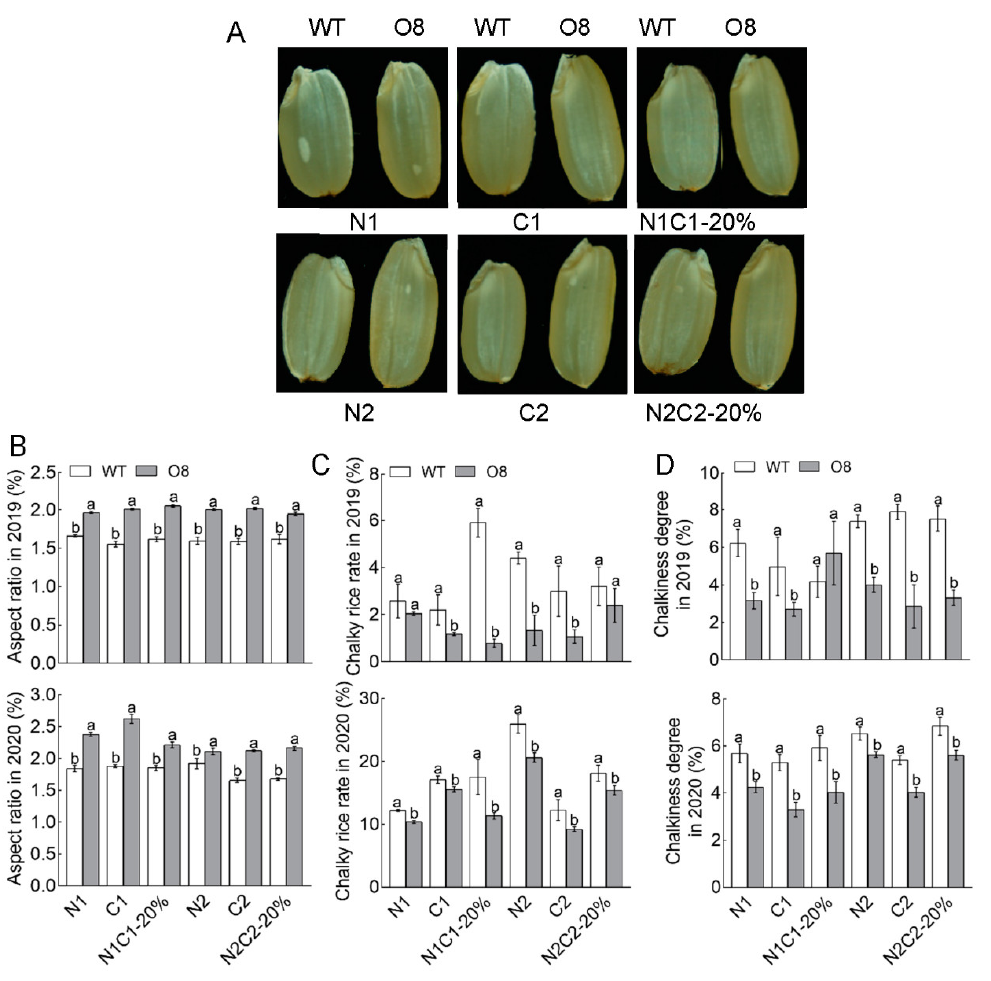
Figure 3. Grain phenotype of overexpression OsNRT2.3b line and wild type. ( A ) Grain phenotype of overexpression OsNRT2.3b lines (O8) and wild type (WT) under different fertilizer treatment conditions. Aspect ratio ( B ), chalky grain rate ( C ), and chalkiness degree ( D ) of O8 and WT under different fertilizer treatment conditions in 2019 and 2020. N1: treatment with 90 kg/ha nitrogen fertilizer. C1: treatment with 90 kg/ha carbon fertilizer. N1C1-20%: 20% carbon fertilizer instead of nitrogen fertilizer (90 kg/ha). N2: treatment with 270 kg/ha nitrogen fertilizer. C2: treatment with 270 kg/ha carbon fertilizer. N2C2-20%: 20% carbon fertilizer instead of nitrogen fertilizer (270 kg/ha). Significant differences between O8 and WT are indicated by different letters ( p < 0.05).